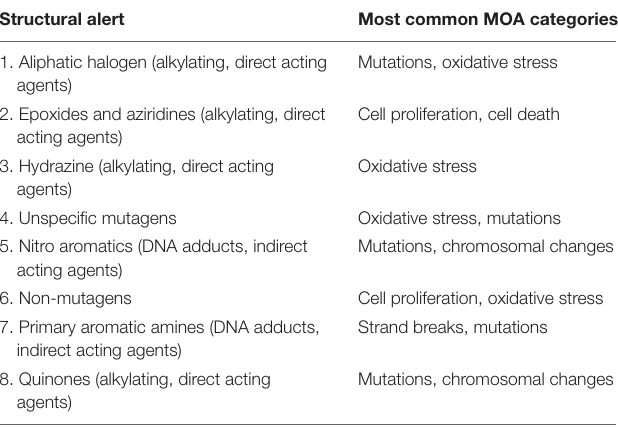
TABLE 4 | Linking structural alerts with carcinogenic MOA information. Structural alert